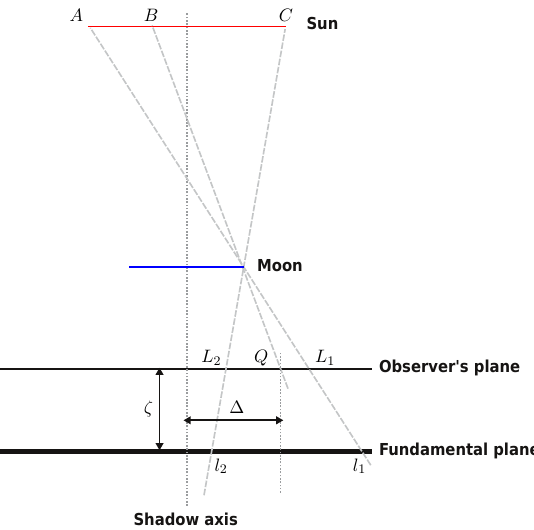
Figure A1. Scheme showing the geometric relationships for deter- mining the degree of obscuration, D , in a total solar eclipse. A sim- ilar scheme can be drawn in an annular